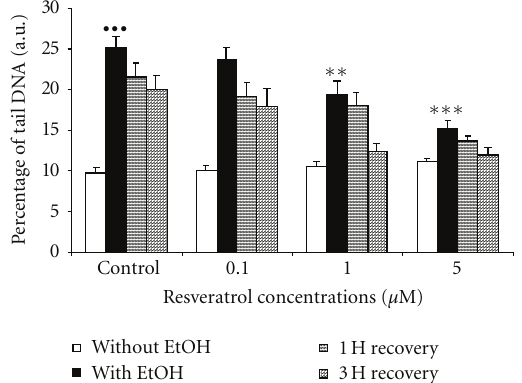
Figure 3: Influence of a 1h pretreatment with various concentra- tions of trans -resveratrol on the level of DNA damage observed in astrocytes exposed to a 3-day treatment with 20mM ethanol, followed or not by a 1 h or 3h recovery period in fresh culture medium. DNA damage was evaluated using the comet assay and is expressed as percentage of DNA in the tail. The figure shows the mean results of three independent experiments. Fifty cells were randomly examined in triplicate for each condition, and results are expressed as mean ± SEM ( ••• P < 0 . 0001 ethanol exposed cells versus control, ∗∗ P < 0 . 05, ∗∗∗ P < 0 . 001 Res + ethanol-treated cells versus control ethanol, Mann-Whitney U test). Experimental conditions are detailed in Section 2. a.u.: arbitrary